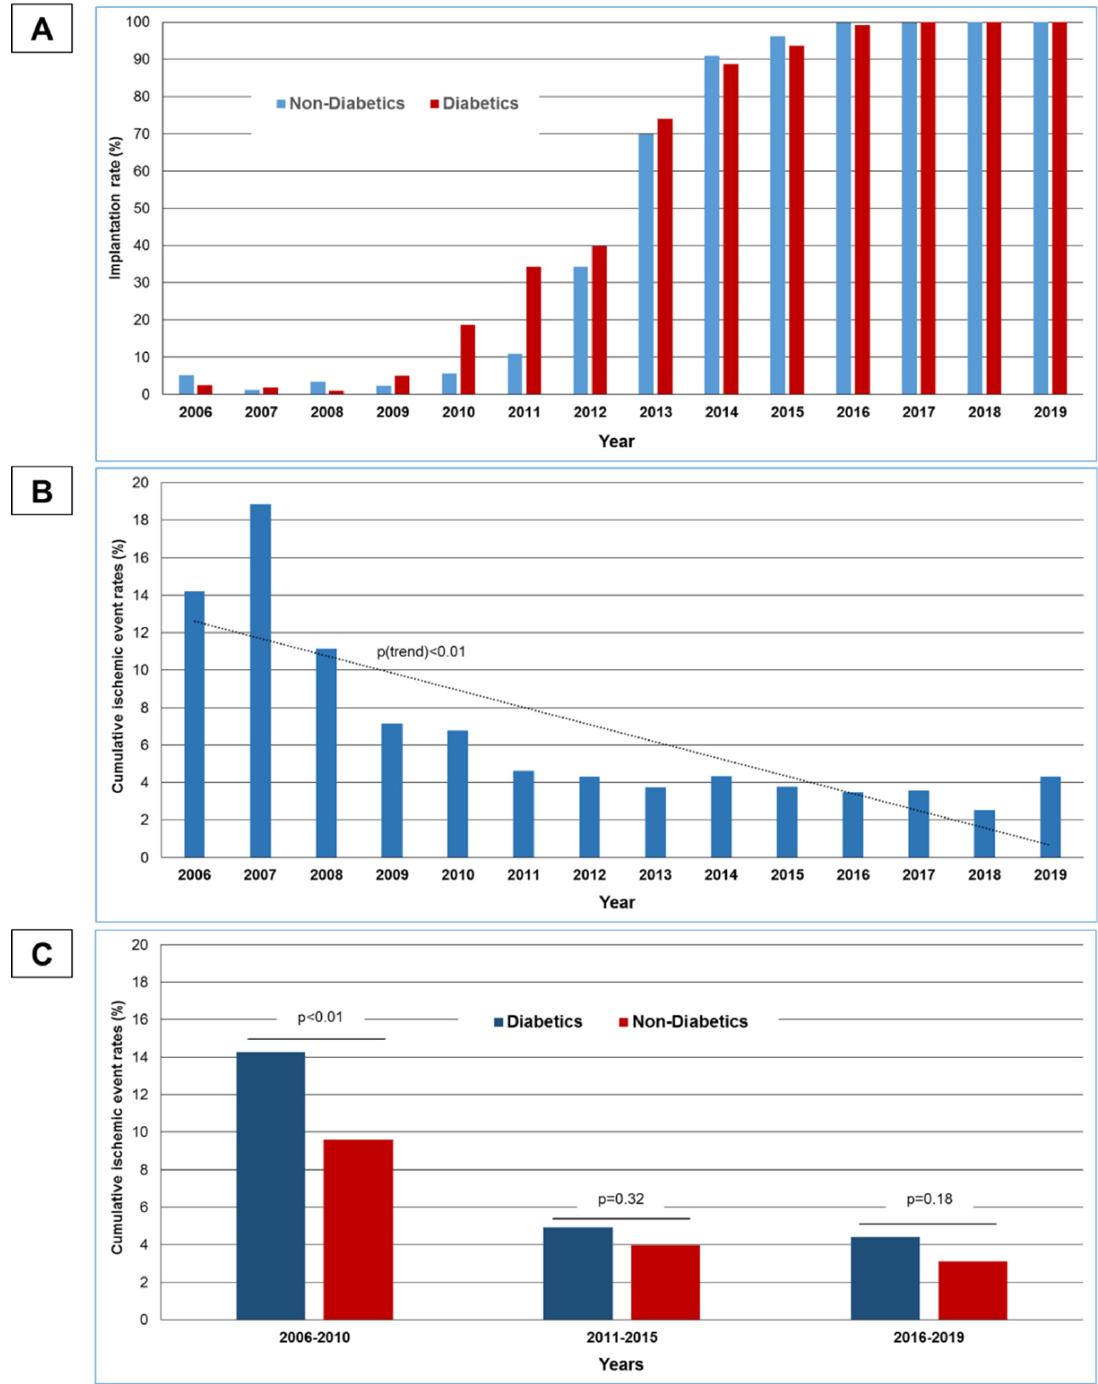
Figure 1. Trends in stent types and adverse ischemic events: ( A ) Proportion of STEMI patients treated with DES in diabetics and non-diabetics 2006–2019. ( B ) Development of cumulative ischemic event rates (ST + AMI + TLR) 2006–2019 in diabetics and non-diabetics. ( C ) Comparison of cumulative ischemic event rates (ST + AMI + TLR) in diabetic and non-diabetic patients in the study cohort.